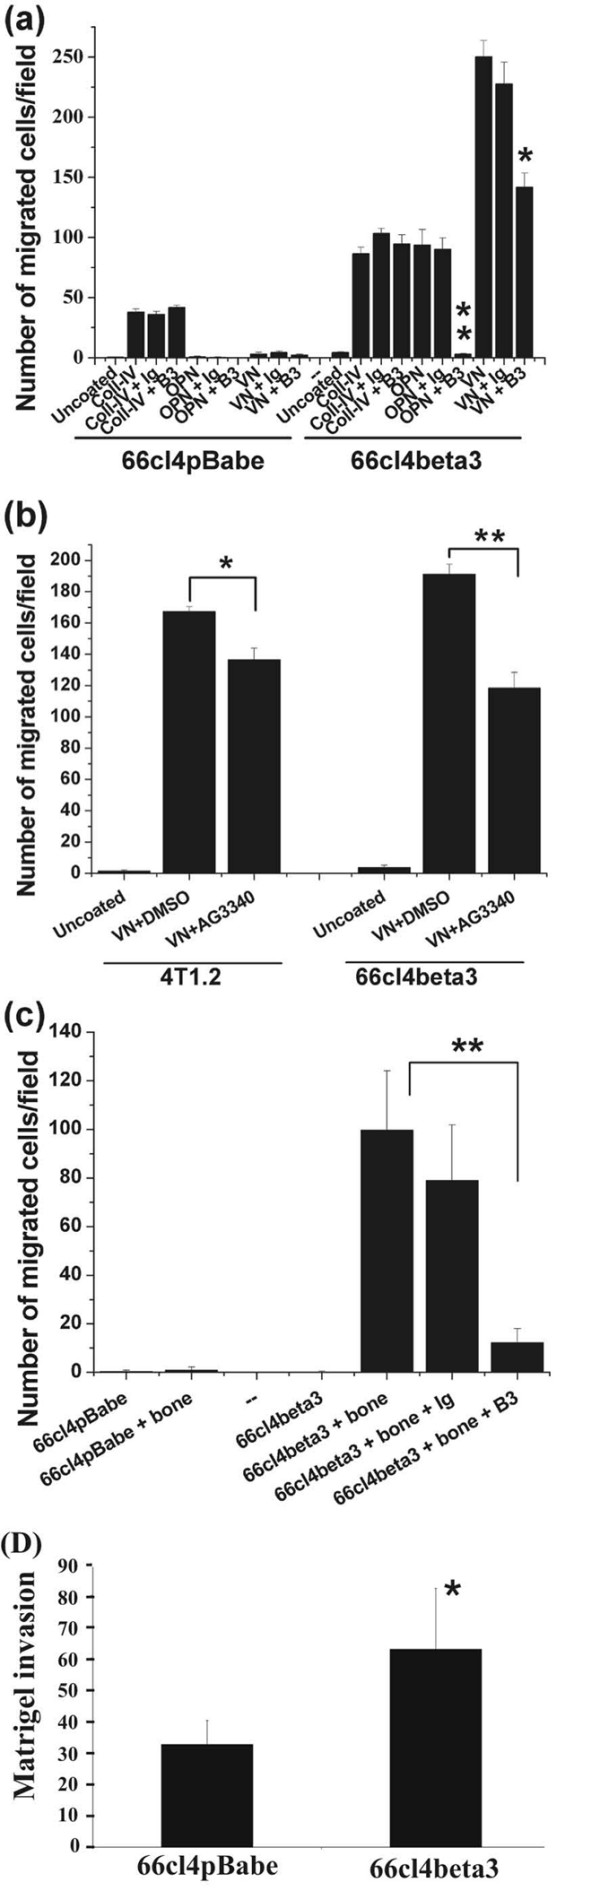
Expression of αvβ3 integrin promotes tumor cell migration and invasion. Migration and Matrigel invasion assays were performed in Transwell migration chambers (8 μm pore size). (a) Haptotactic migration in response to collagen IV, osteopontin and vitronectin and the effect of neutralizing β3 antibodies. (b) Effect of the matrix metalloproteinase inhibitor AG3340 (10 μM) on the haptotactic migration of 4T1.2 and 66cl4beta3 cells. (c) Chemotactic migration of 66cl4pBabe and 66cl4beta3 cells towards a monolayer of bone stromal cells seeded in the lower chamber. (d) Invasion of cells through Matrigel in response to a serum chemotactic gradient. All assays were performed in duplicate wells and the cells counted from three fields of view/membrane at 40× magnification (a, b and d) or 20× magnification (c). The experiments were repeated at least twice and the data represent the mean number of migrated cells ± standard deviation of six fields of view/condition from a representative experiment performed in duplicate wells. *P < 0.01, **P < 0.001.